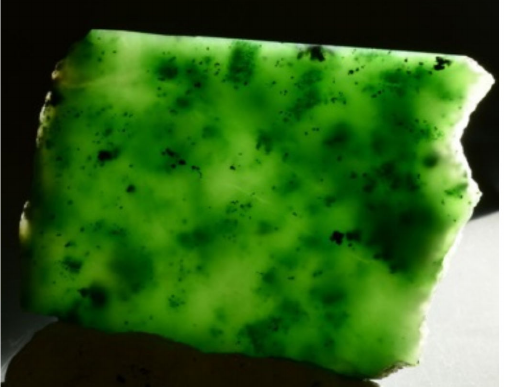
Figure 3. Translucent polished nephrite cut. Black dots are chromites. Plate 8 cm × 5 cm. South quarry. Sample by A.B. Loskutov and E.A. Novgorodova, photo by M.B. Leibov